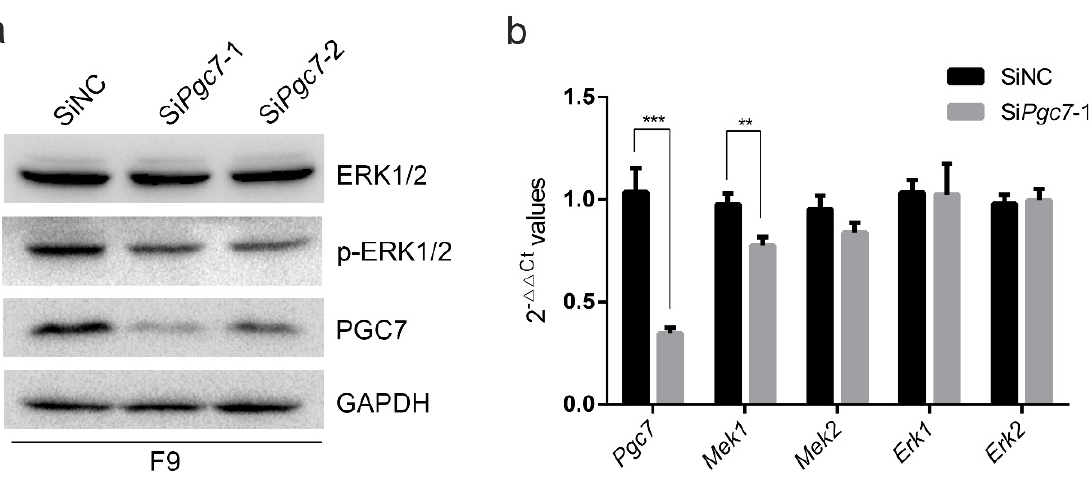
Figure 3. PGC7 regulates ERK activity by regulating Mek1 transcription. ( a ) Knockdown of PGC7 resulted in the downregulation of ERK phosphorylation in F9 cells. F9 cells were transfected with SiNC or Si Pgc7 for 36h, after which a Western blot was performed. ( b ) The transcription levels of Mek1 , Mek2 , Erk1 , and Erk2 in F9 cells in which Pgc7 was knocked down. F9 cells were transfected with SiNC or Si Pgc7 -1 for 36 h prior to the extraction of total RNA. RT-qPCR was performed after reverse transcription. Data are presented as means ± SD for quantitative analysis. *** p < 0.001, ** p < 0.01.